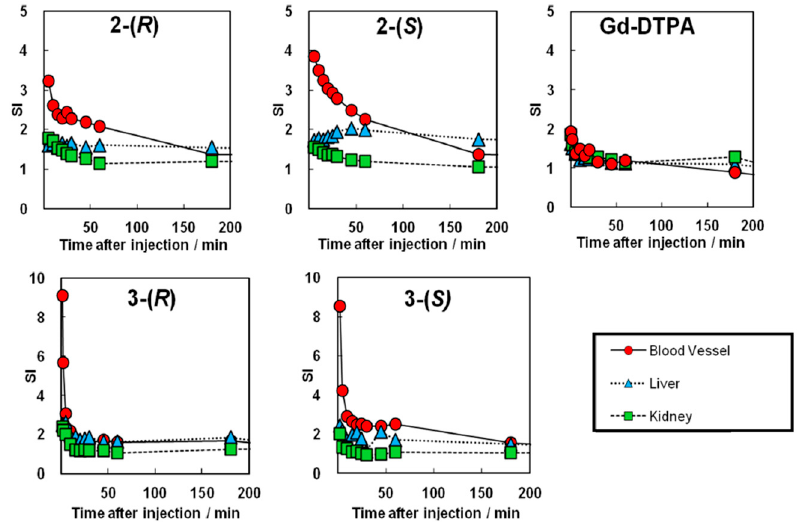
Figure 5. Post/pre signal intensity (SI) enhancement of mouse tissues after intravenous injection of Gd-DTPA, 2 -( R ), 2 -( S ), 3 -( R ) and 3 -( S ) (0.10 mmol